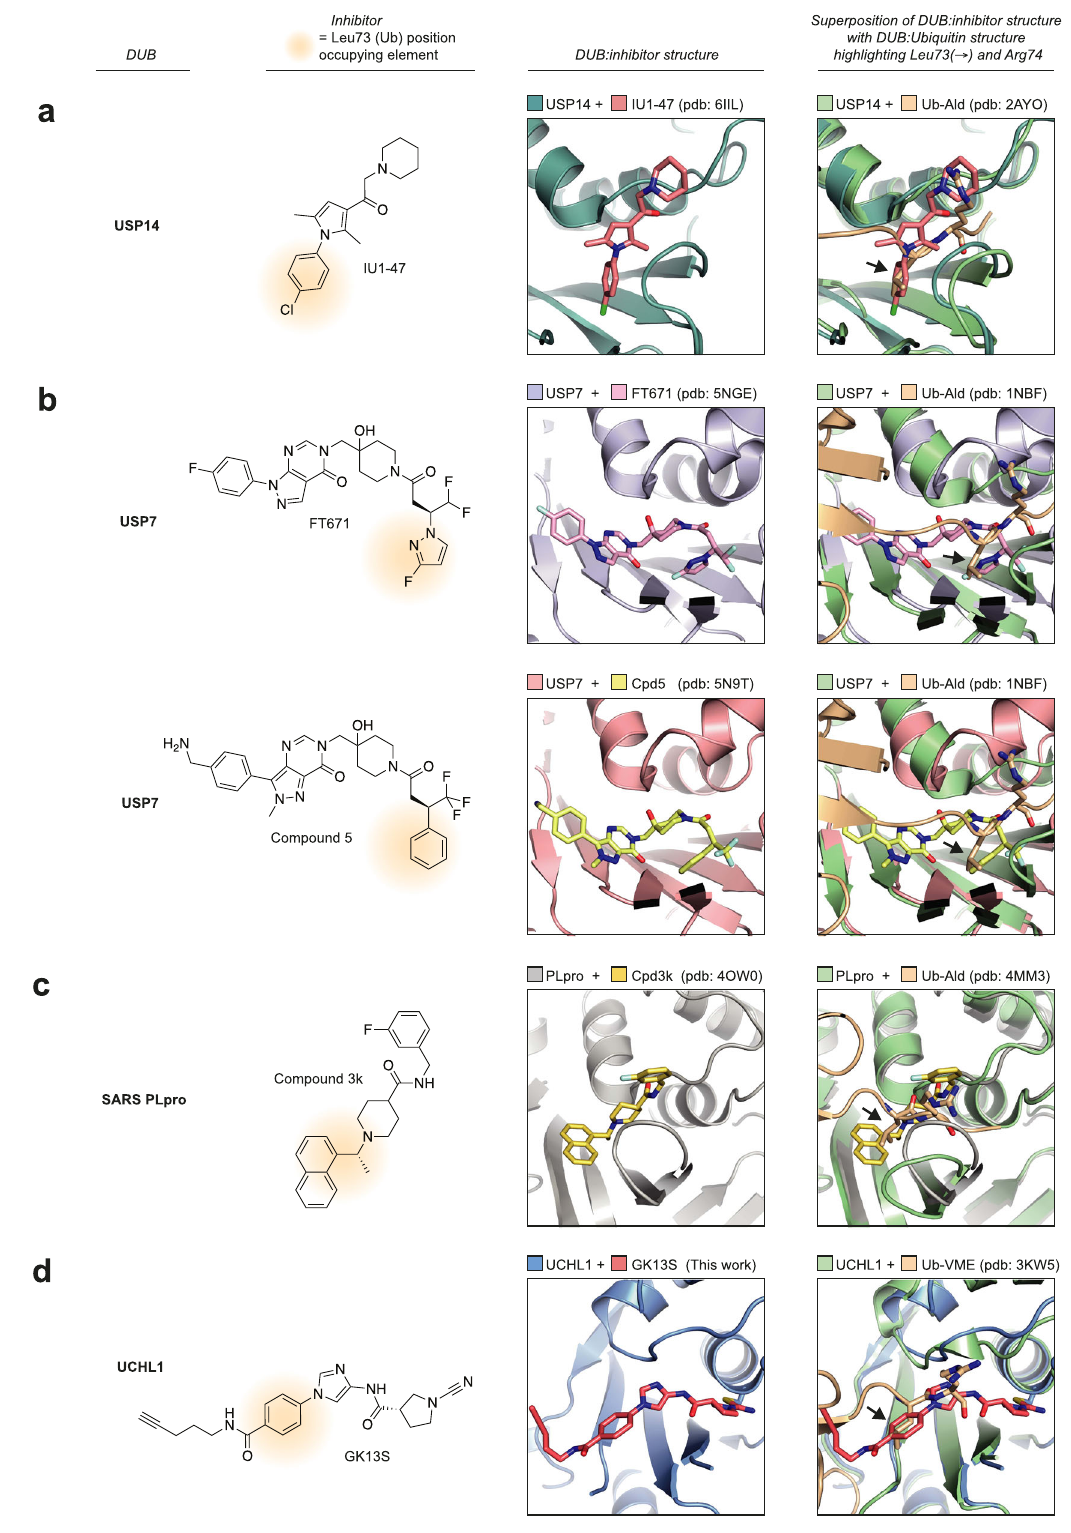
Fig. 7 | A potential hotspot for DUB ligandability across families. a – d Selection of structurally characterized DUB inhibitors of USP14 50 ( a ), USP7 44,51 ( b ), SARS PLpro 52 ( c ),and UCHL1 ( d ). Shown are the structuresof the compounds, aclose-up view of their binding pockets from co-crystal structures, and overlays of these co-